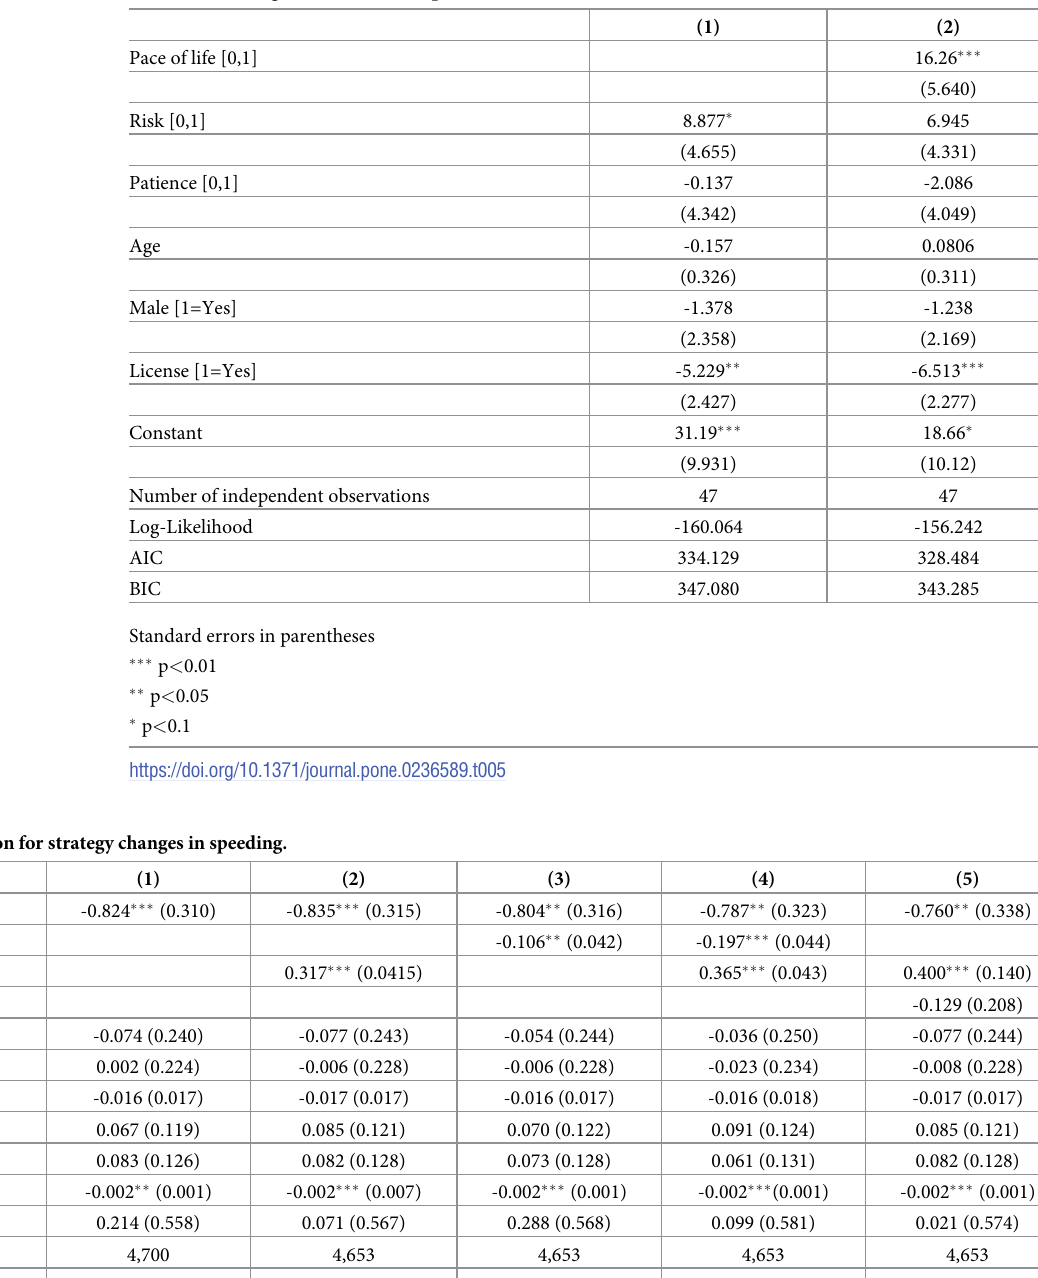
Table 5. Tobit regression of the independent variable fast (cumulative).